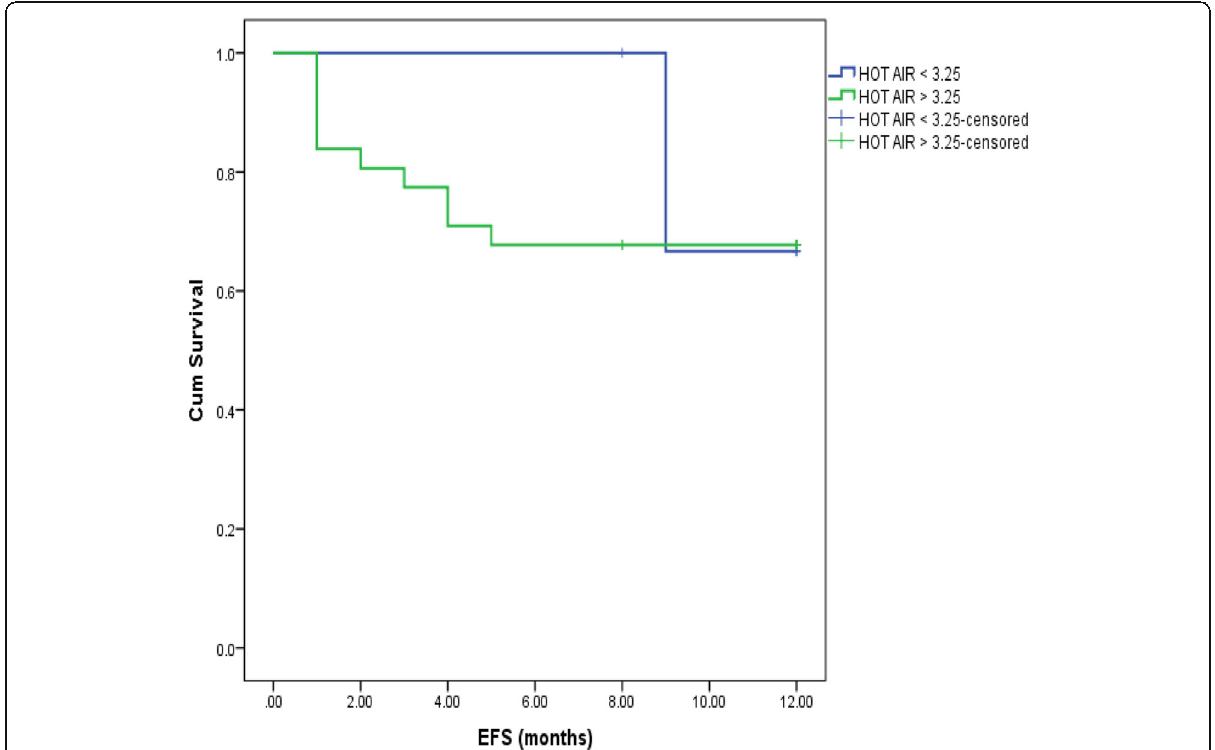
Fig. 5 Cumulative survival of AML patient group during study